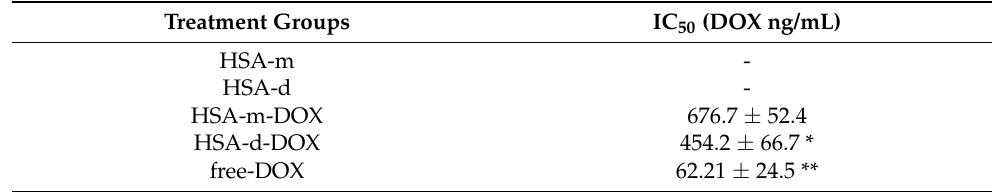
Table 2. IC 50 of DOX derives against pancreatic tumor